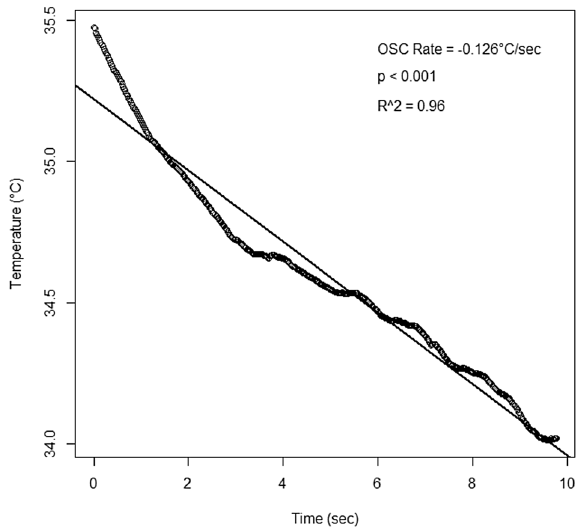
Figure 3. Change in ocular surface temperature over time to obtain the OSC rate for each subject.